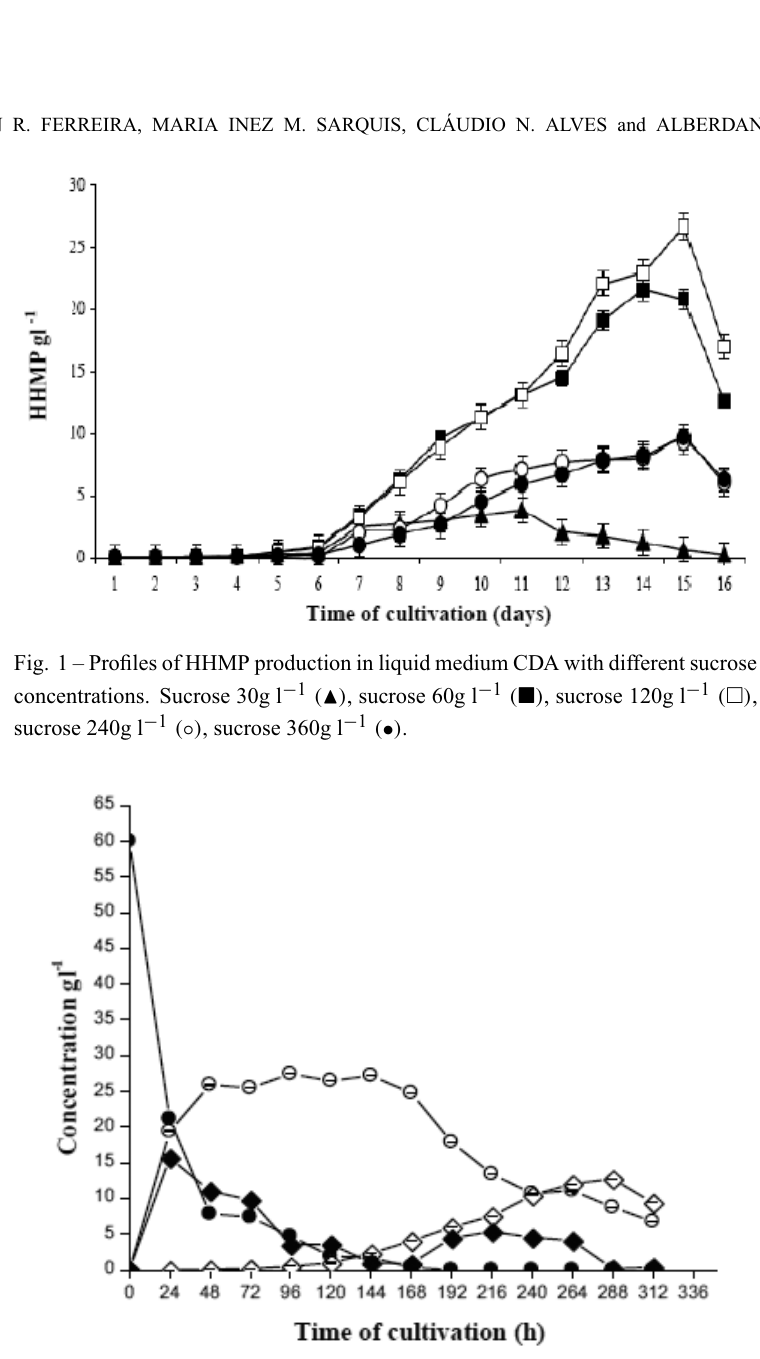
Fig. 2 – Profiles of sucrose hydrolyze, fructose isomerase into glucose and its consumption: Sucrose ( • ) , HMPP ( ◦ ) , glucose ( (cid:7) ) , fructose ( ♦ )